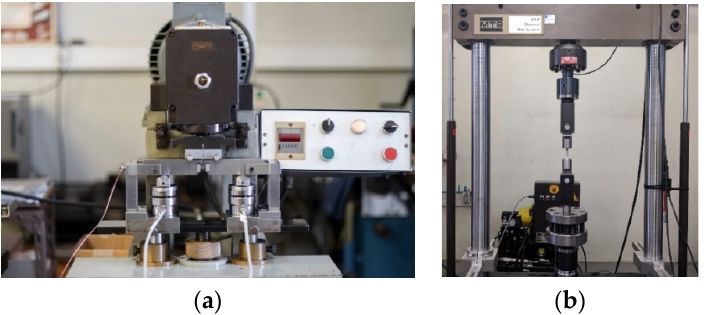
Figure 4. Fatigue testing setup: ( a ) Miniature bending apparatus (pure bending); ( b ) Standard axial setup [17].